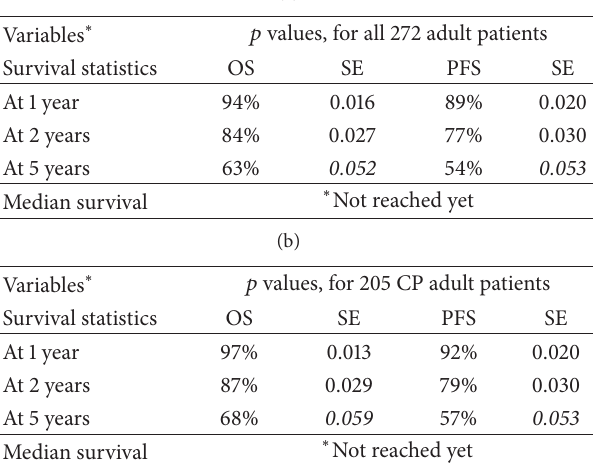
Table 4: Univariate analysis of all 205 chronic phase patients’ characteristics as predictors of overall and progression-free